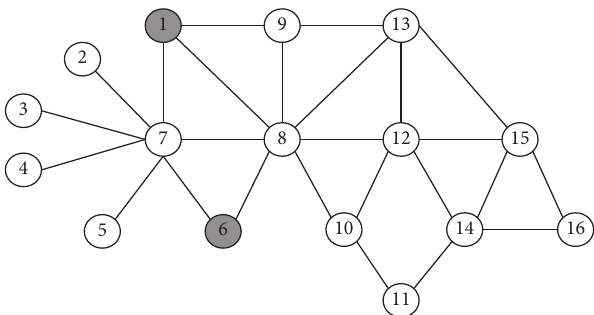
Figure 1: (Color online) The sample network in the figure has 16 nodes as well as 25 edges. The SIR model can be used to simulate the nodes’ real spreading influence, that is, the amount of the infected nodes can be considered as spreading influence. We set β � 0.2 and μ � 1, and the number of simulations are 10 3 . Therefore, we can get results of 2.405 and 2.101, respectively, for the spreading influence of nodes 1 and 6. With the IE method, the influence of nodes 1 and 6 should be 1.875 and 2.023, respectively.